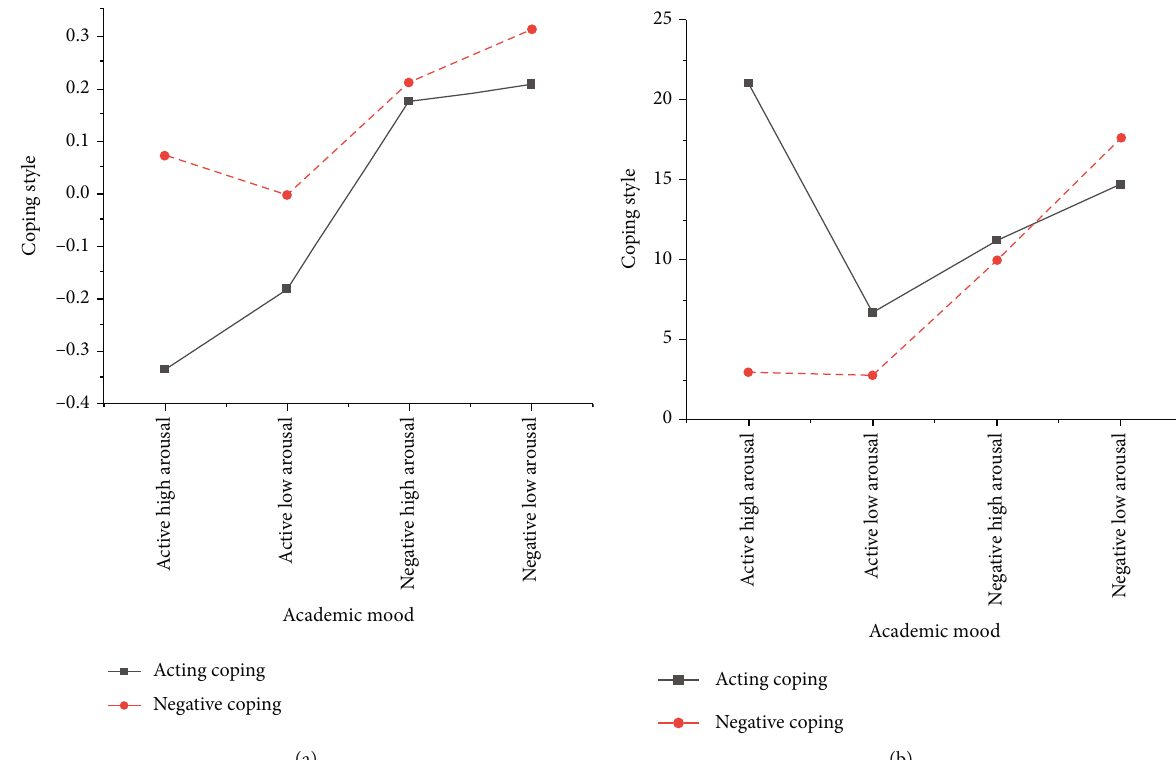
Figure 10: The analysis of the types of coping styles and academic emotions of art students ((a) correlation analysis between coping style types and academic emotions and (b) regression analysis between coping style types and academic